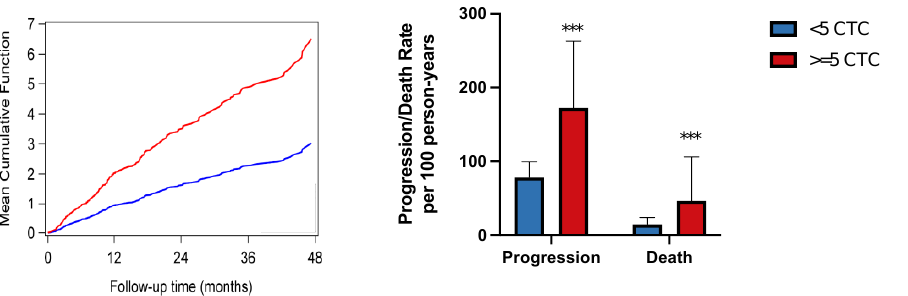
Figure 2. CTC count ≥ 5 is prognostic at the start of therapy for MBC. ( a ) Forest plots showing Cox proportional hazard for ≥ 5 CTCs/~9.5 mL of blood at each timepoint for PFS and OS. ( b ) Kaplan- Meier plots for PFS and OS stratified by ≥ 5 CTCs ~9.5 mL of blood. ( c ) Kaplan-Meier plots stratified by clearance of ≥ 5 baseline CTCs by visits 2 and 3. ( d ) Mean cumulative progression events for ≥ 5 CTCs vs. <5 CTCs at baseline and progression and death rates per 100 person-years. CTC, circulating tumor cell; OS, overall survival; PFS, progression-free survival. *** p < 0.0001. In a multivariate Cox analysis that included age and tumor subtype (as determined from a biopsy of metastatic tumor tissue), a CTC count of ≥ 5 CTCs remained an inde- pendent prognostic factor for PFS and OS at 3 months, 15 months, and 18 months but only for PFS at baseline (Figure S5). Repeated CTC enumeration using archived images by an independent observer, while not independent of the original count, was also an independent prognostic factor when substituted for the initial count (for example, in the baseline model of PFS, HR = 2.58, p < 0.001 for the independent repeated